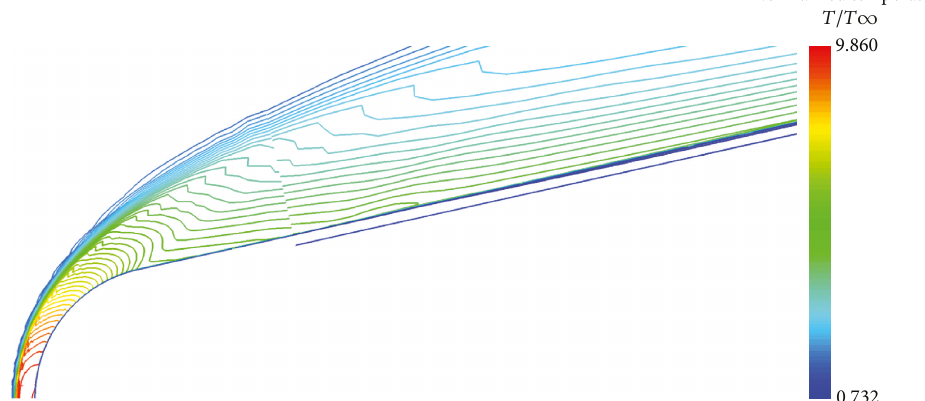
Figure 24: Normalized temperature, mass fl ow 0.55kg/S, Re = 4 3 × 10 6 , α = 0 0 ° , M = 6 8 .